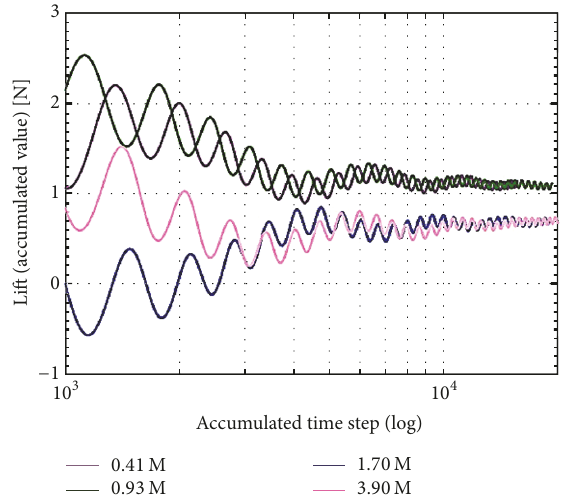
Figure 3: Accumulated mean values of the lift force for 4 different mesh densities consisting of 0.41, 0.93, 1.7, and 3.9 million elements. Table1:Discretizationerrorforicedairfoilinatransientsimulation. Simulation type Transient (2D) Criteria